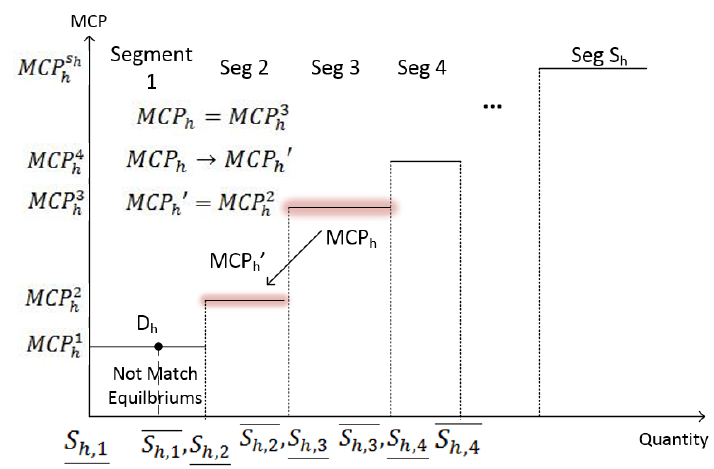
Figure 5. An example of the new method.